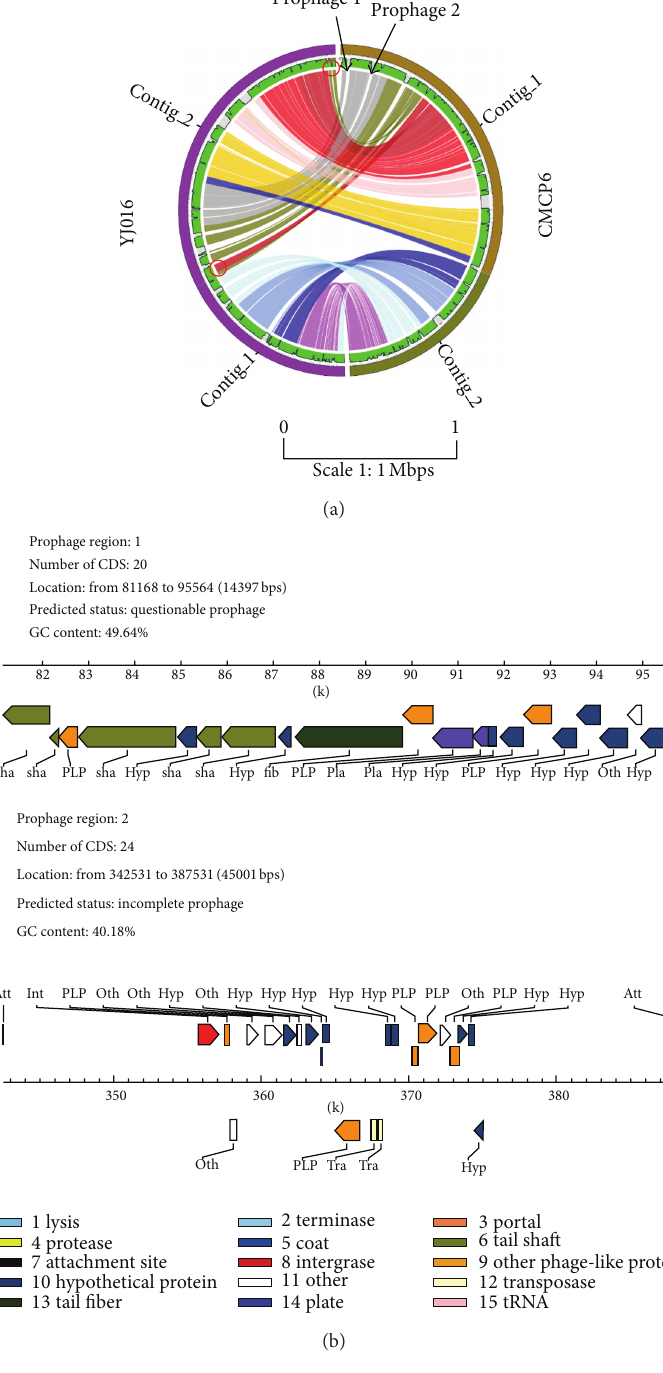
Figure 2: Example of a pairwise genome alignment between V. vulnificus YJ016 and V. vulnificus CMCP6. (a) Circos plot reveals differences betweenthetwogenomes.Redcircleindicatesthetranslocationspossiblyoccur.Blackarrowheadsindicatephageinsertions.(b)Thestructure of the two putative prophages. (Scale of the Circos